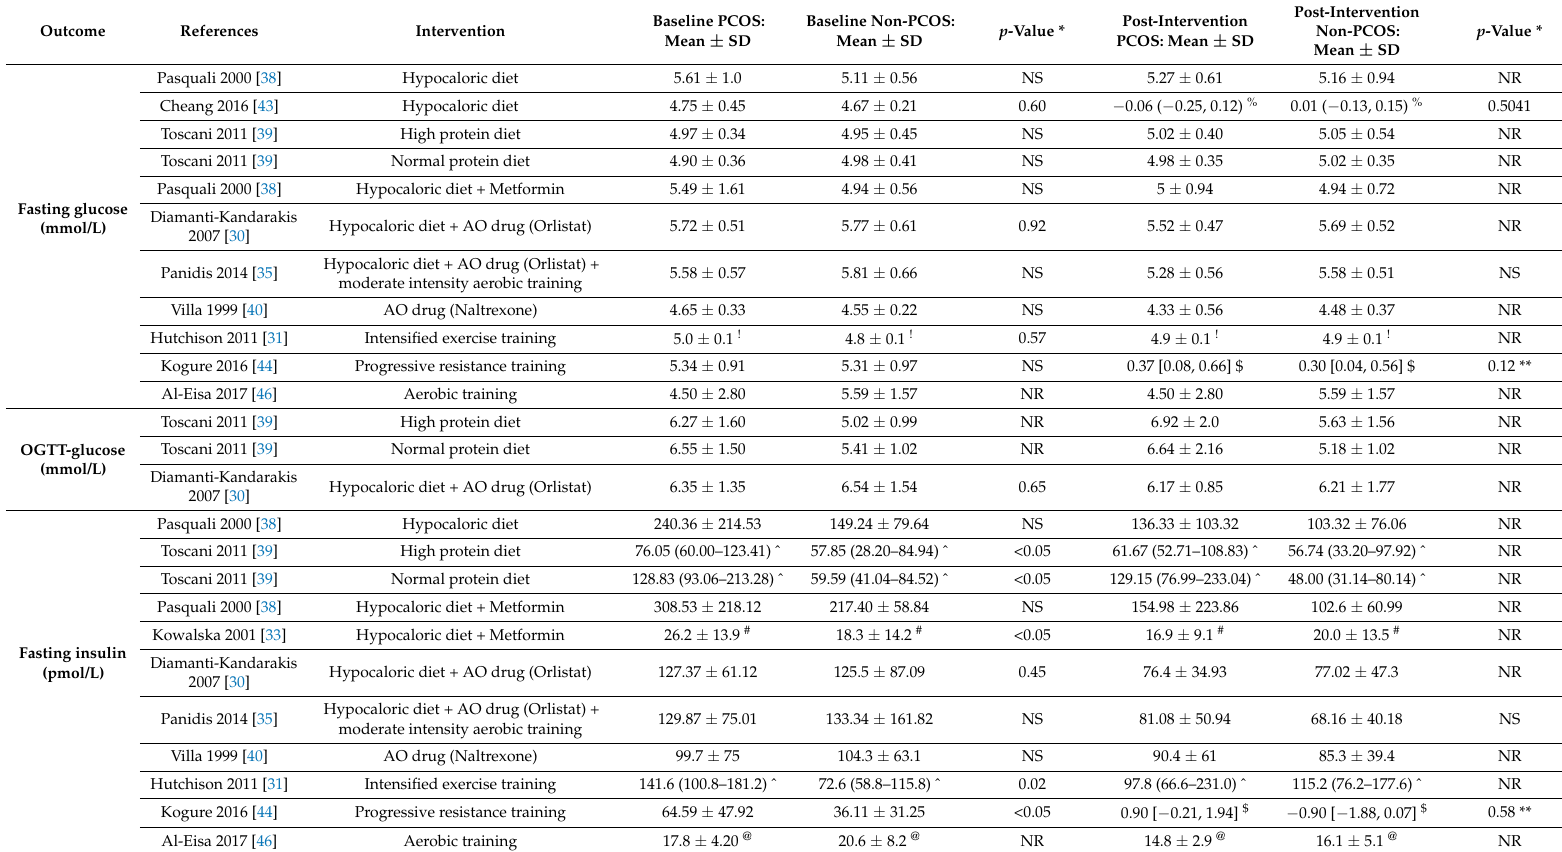
Table 4. Glucose and insulin homeostasis.